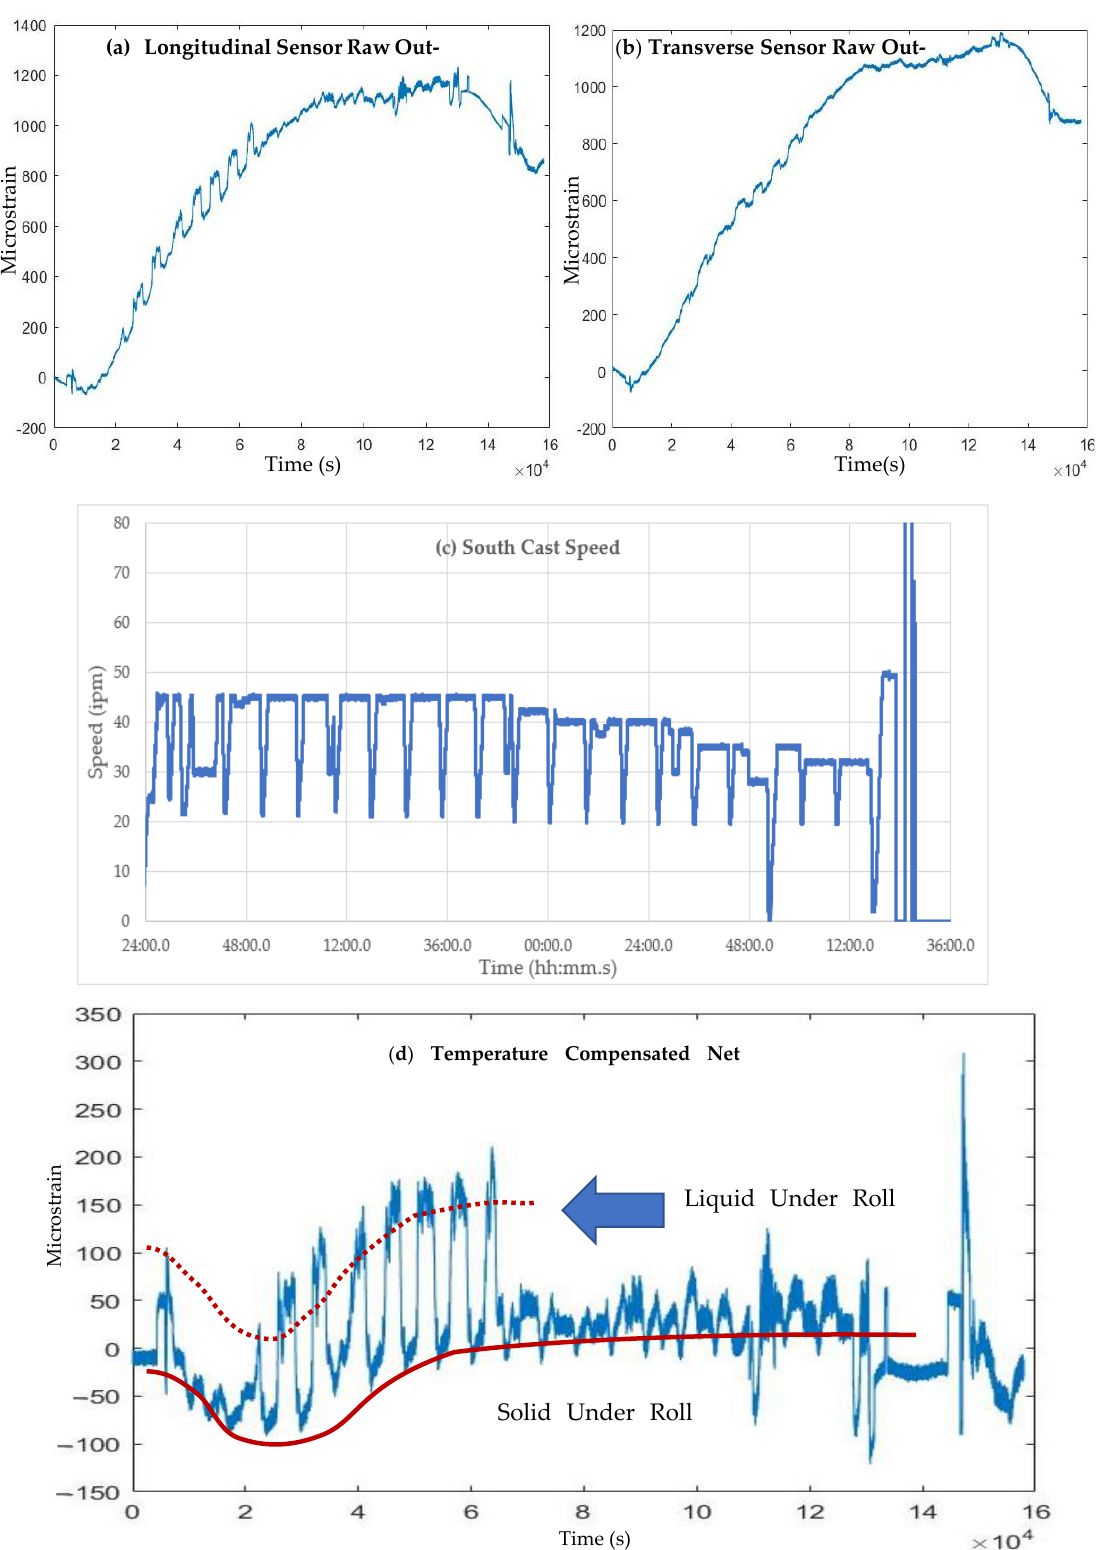
Figure 16. Raw optical sensor microstrain measurements for a 20-heat cast sequence: ( a ) longitudinal sensor output, ( b ) transverse sensor output, ( c ) casting speed for sequence, and ( d ) net temperature compensated strain (signal a–signal b).